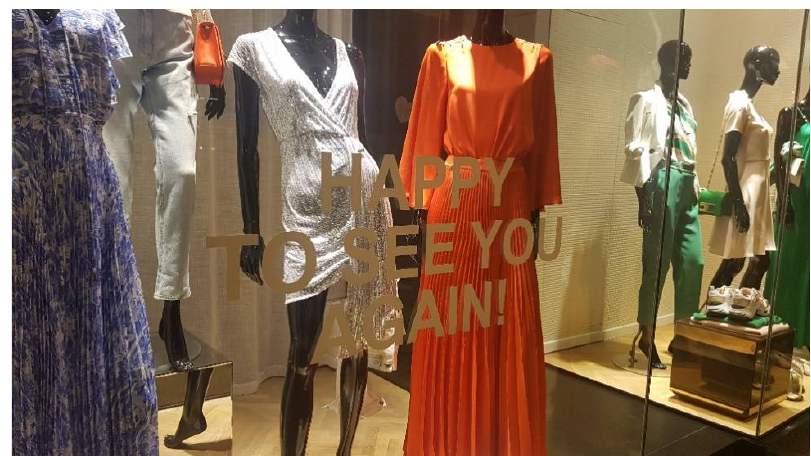
Figure 17. Happy to see you again!